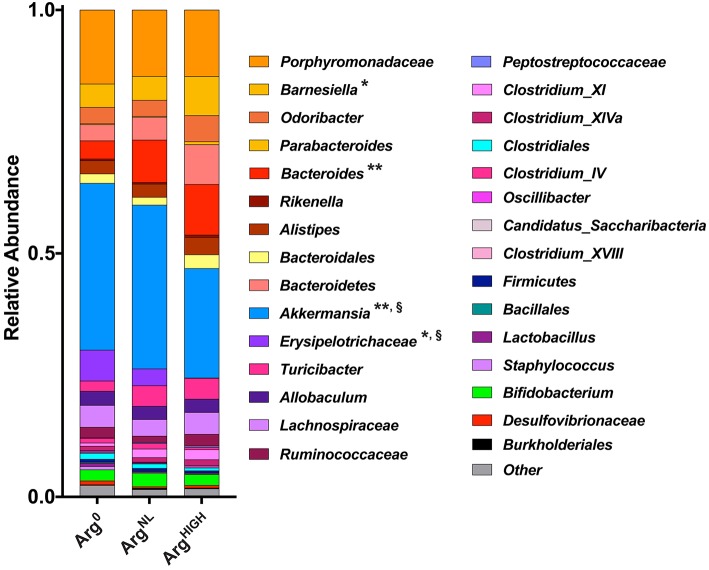
Composition of the gut microbiota at the genus level. Variation in bacterial community composition at genus levels expressed as a percentage of the total community. *P < 0.05, **P < 0.01 denotes significant difference vs. Arg0 group; §P < 0.05, compared to the ArgNL group; statistics were performed using ANOVA with the Tukey test.